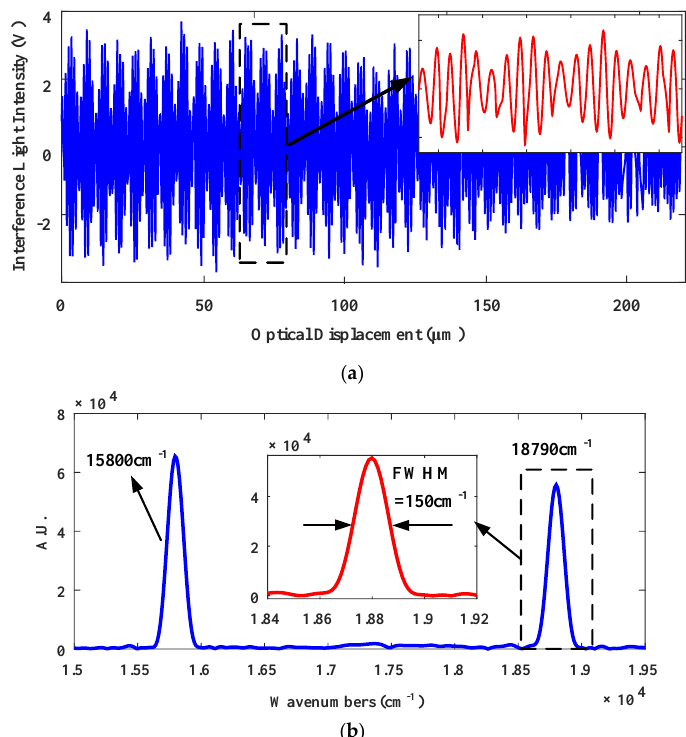
Figure 21. Under PID control: ( a ) the reconstructed interferogram of the testing light in spatial domain testing light; ( b ) spectrum recovered of the testing light.